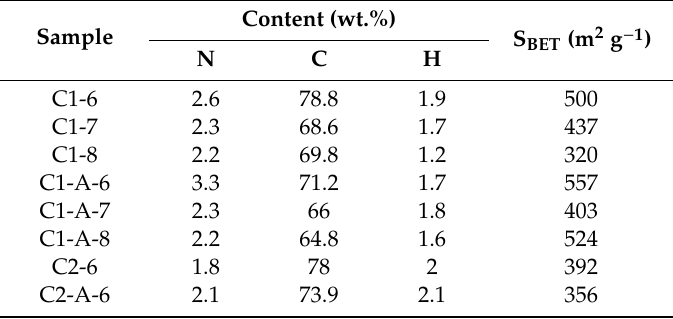
Table 2. Specific surface area and elemental composition by combustion analysis of hybrid carbon